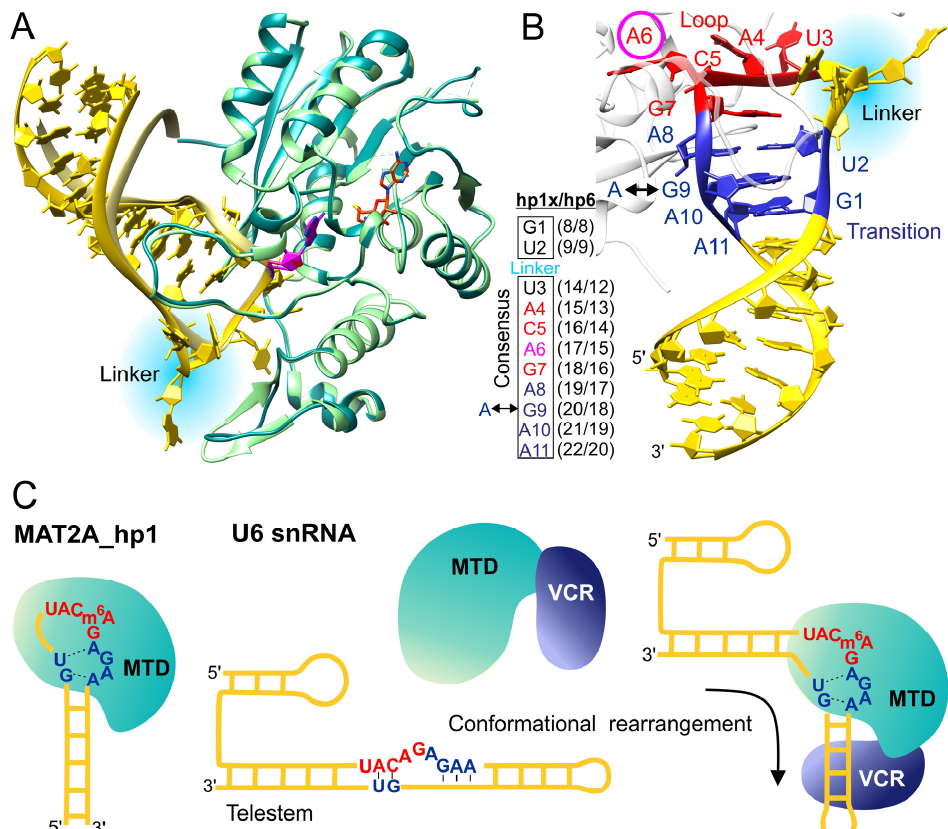
Figure 2. Interaction between METTL16 and RNA methylation substrates. ( A ) Superposition of two crystal structures of METTL16-MTD/RNA complex, PDB ID: 6du4 (METTL16, turquoise; hp1x, gold), 6du5 (METTL16, light green; hp6, light yellow); the acceptor adenosine is shown in magenta; SAH is superimposed from the structure 6b92 and shown as sticks (orange). The linker differentiating the loop-transition region of hp1x and hp6 is highlighted by light blue. ( B ) The hp1x of METTL16- MTD/RNA complex (6du4) is shown in atoms-ribbon representation. The 3 (cid:48) part of the loop and the transition region are marked by red and blue colors, respectively. The acceptor adenosine is manifested by the magenta circle. The linker between the transition region and the loop is highlighted by light blue. METTL16 is shown by a transparent white ribbon. The conserved sequence of the loop-transition structure is numbered 1–11, with 6 (magenta) representing the acceptor adenosine. Schematic representation of loop-transition region (inset) shows conserved residues (1–11, box) and corresponding nucleotides in hp1x and hp6 models. The arrow indicates the G/A substitution in hp5. ( C ) A schematic diagram of the interaction between METTL16 and its RNA substrates ([36], figure modified): MAT2A mRNA and U6 snRNA. The loop and transition regions are marked as in panel B. The VCRs of METTL16 associate with U6 and rearrange the substrate to obtain the conformation optimal for